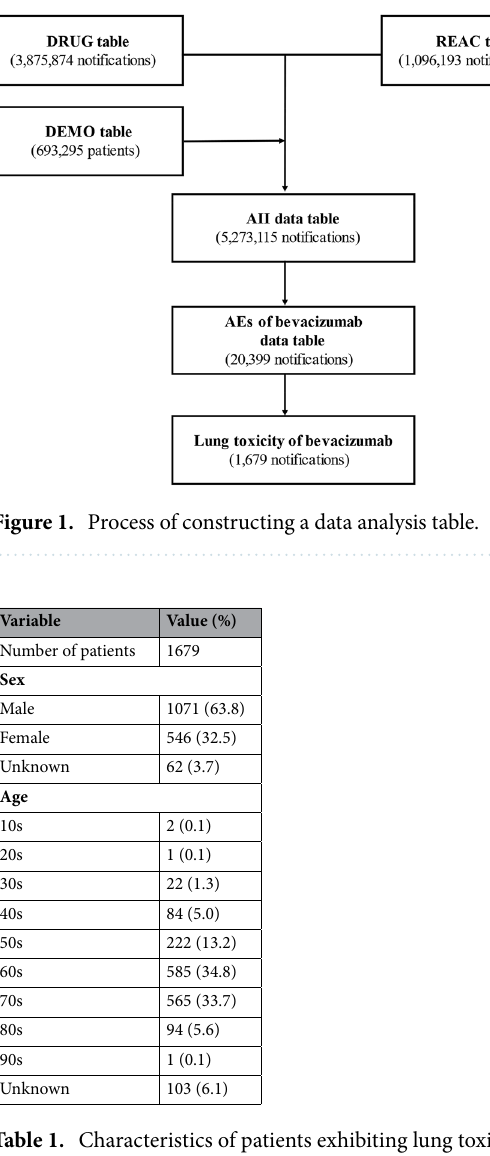
Table 1. Characteristics of patients exhibiting lung toxicities related to